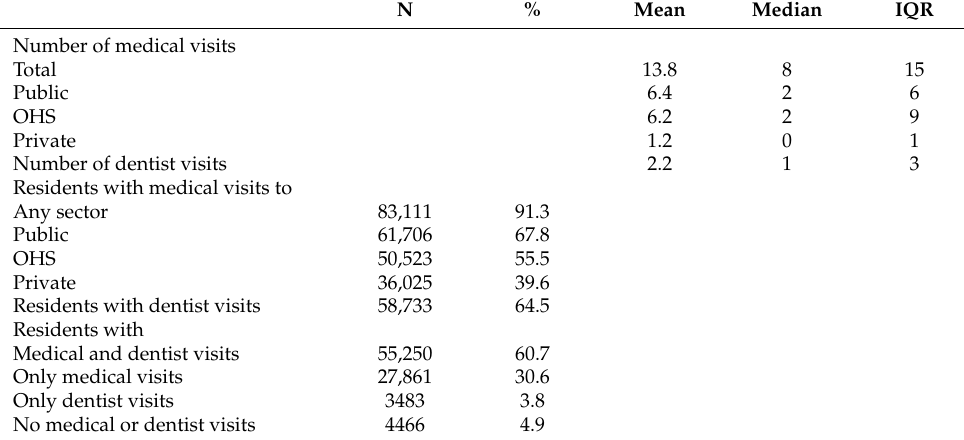
Table 2. Descriptive statistics for medical and dentist visits during years 2017–2018.